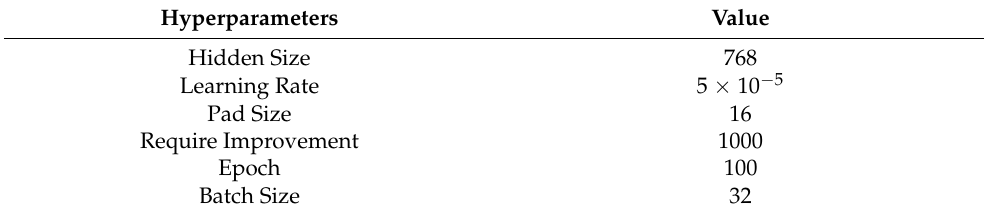
Table 3. Hyperparameters of ERNIE and BERT.